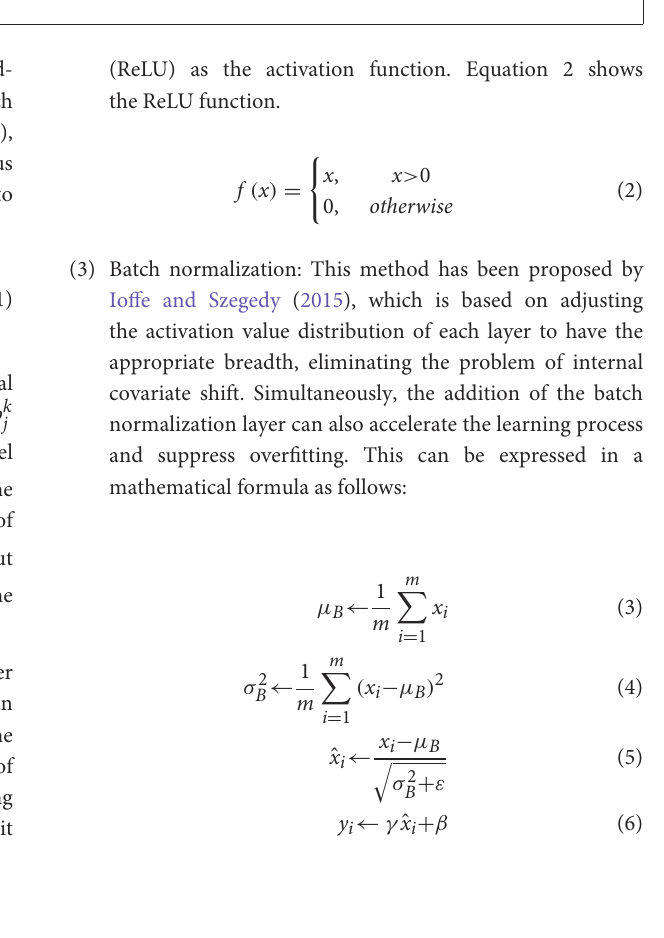
FIGURE2 Multi-input deep convolutional neural